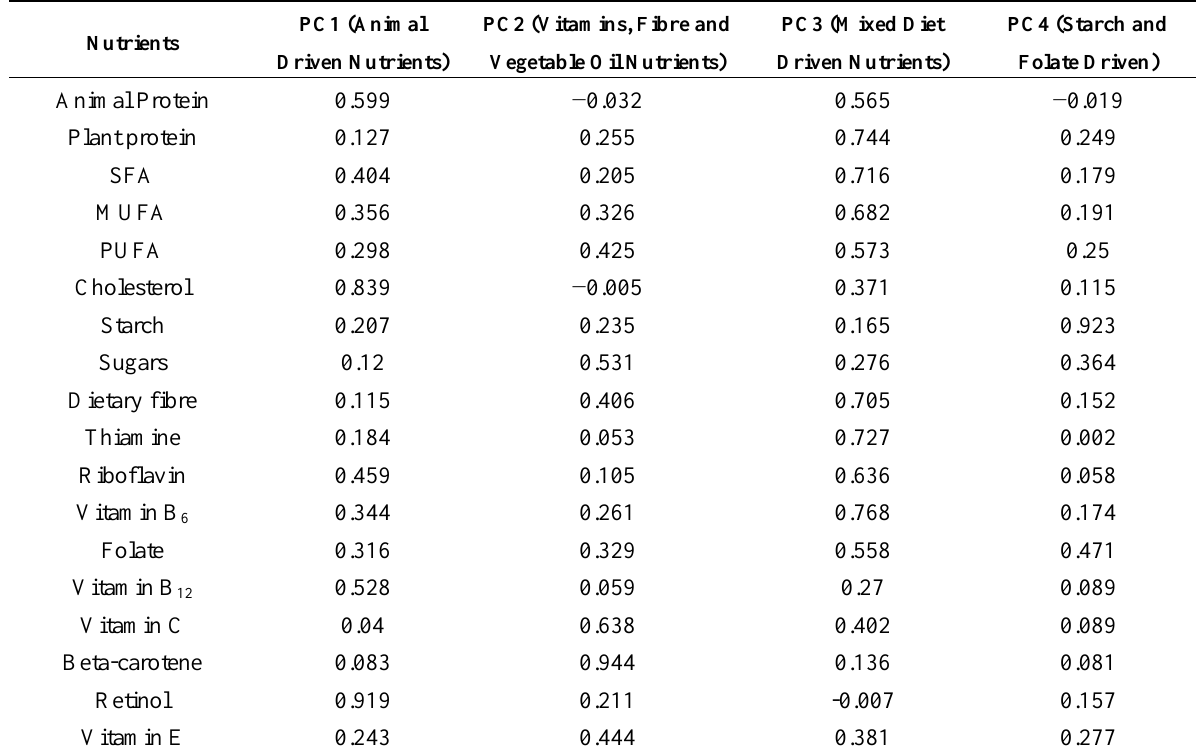
four nutrient patterns identified by PCA in rural black South African adolescents: